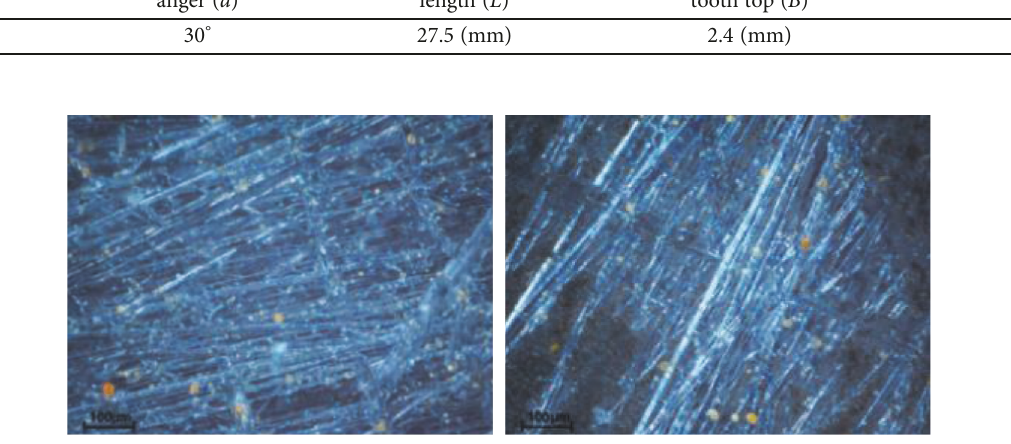
Figure 7: Surface topography by industrial microscopes of worn material specimen.